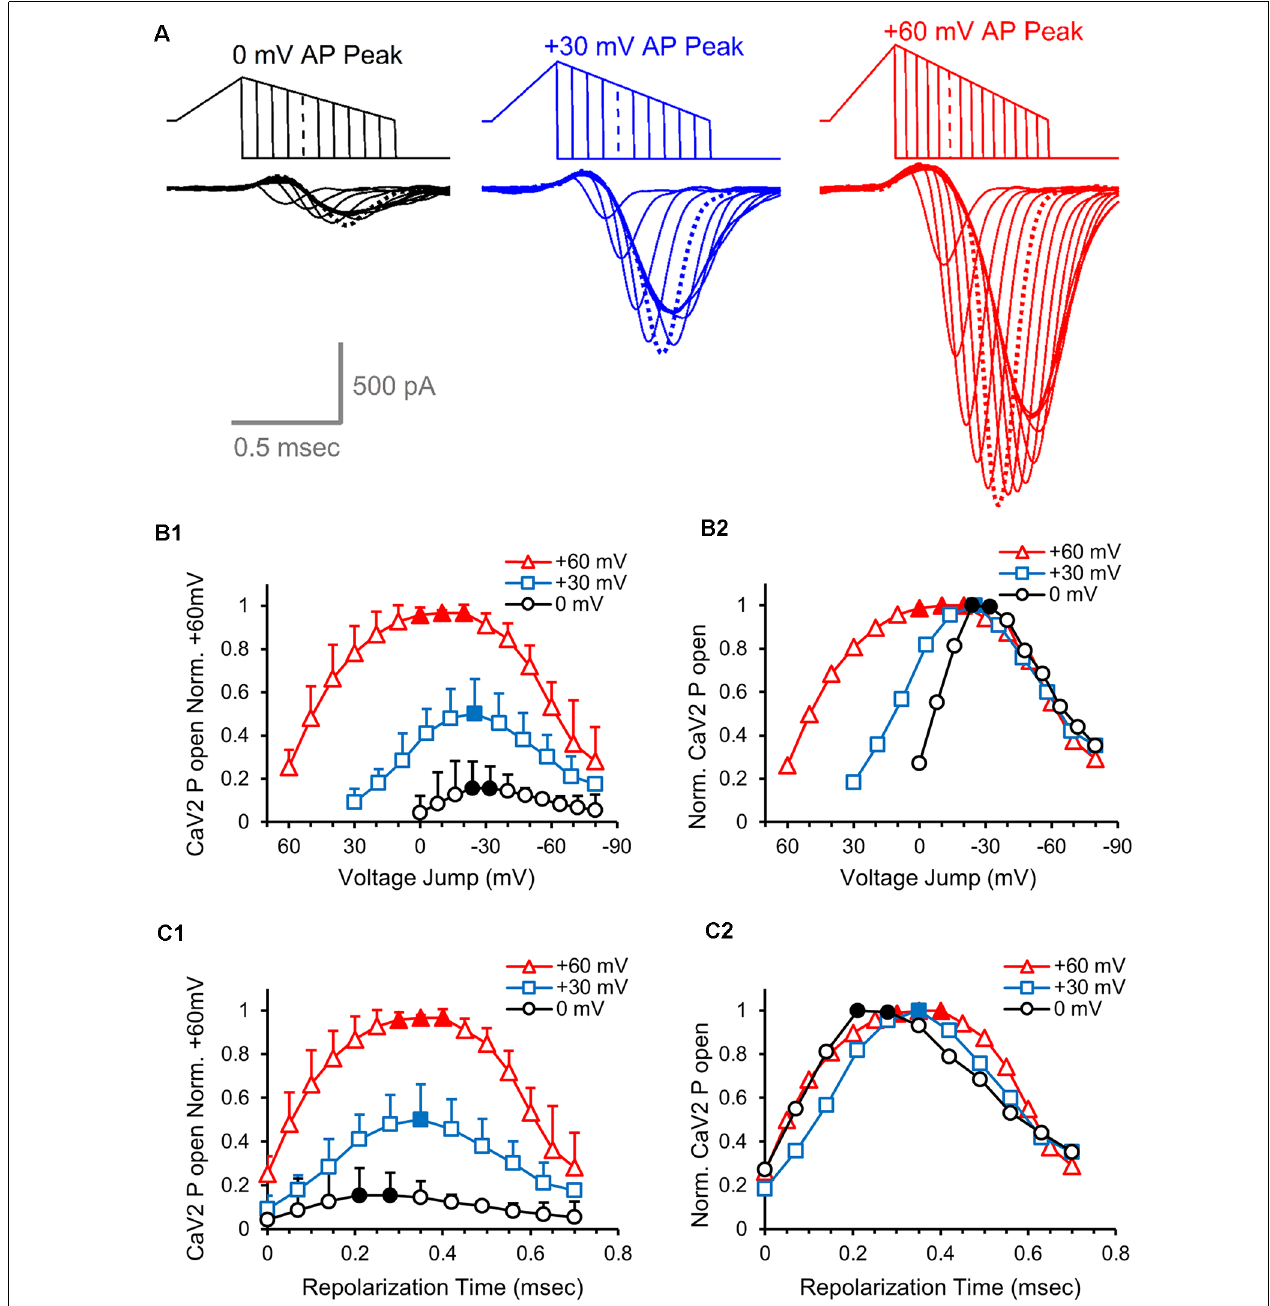
FIGURE 7 | Effects of action potential amplitude on the number of active calcium channels at different times during the action potential. (A) Overlay of presynaptic CaV2 responses to hyperpolarizing voltage-jumps used to determine the relative number of open CaV2 channels at different points during the repolarization phase of an AP-like stimulus with peak amplitudes of 0 mV (black), 30 mV (blue) or 60 mV (red). Peak activation levels are indicated by dashed lines. (B1) Cav2 open probability measured by the peak amplitudes of the CaV2 responses to hyperpolarizing voltage-jumps. The values from each cell were normalized to the responses from the +60 mV stimulus, and the normalized data from each cell were averaged. The graph shows the relative differences in the number of active CaV2 channels at different repolarization membrane potentials for AP-like stimuli that peak at 0, 30 or 60 mV. Panels (B1–C2) , n = 5 cells. (B2) Relative CaV2 open probability produced by normalizing the values from panel (B1) to the peak response generated by each stimulus. (C1) Cav2 open probability measured by the peak amplitudes of the CaV2 responses to hyperpolarizing voltage-jumps. The data shown are from panel (B1) , with the values adjusted to show the response at specific repolarization times for the AP-like stimuli that peak at 0, 30 or 60 mV. The values from each cell were normalized to the responses from the +60 mV stimulus, and the normalized data from each cell were averaged. (C2) Relative CaV2 open probability produced by normalizing the values from panel (C1) to the peak response generated by each